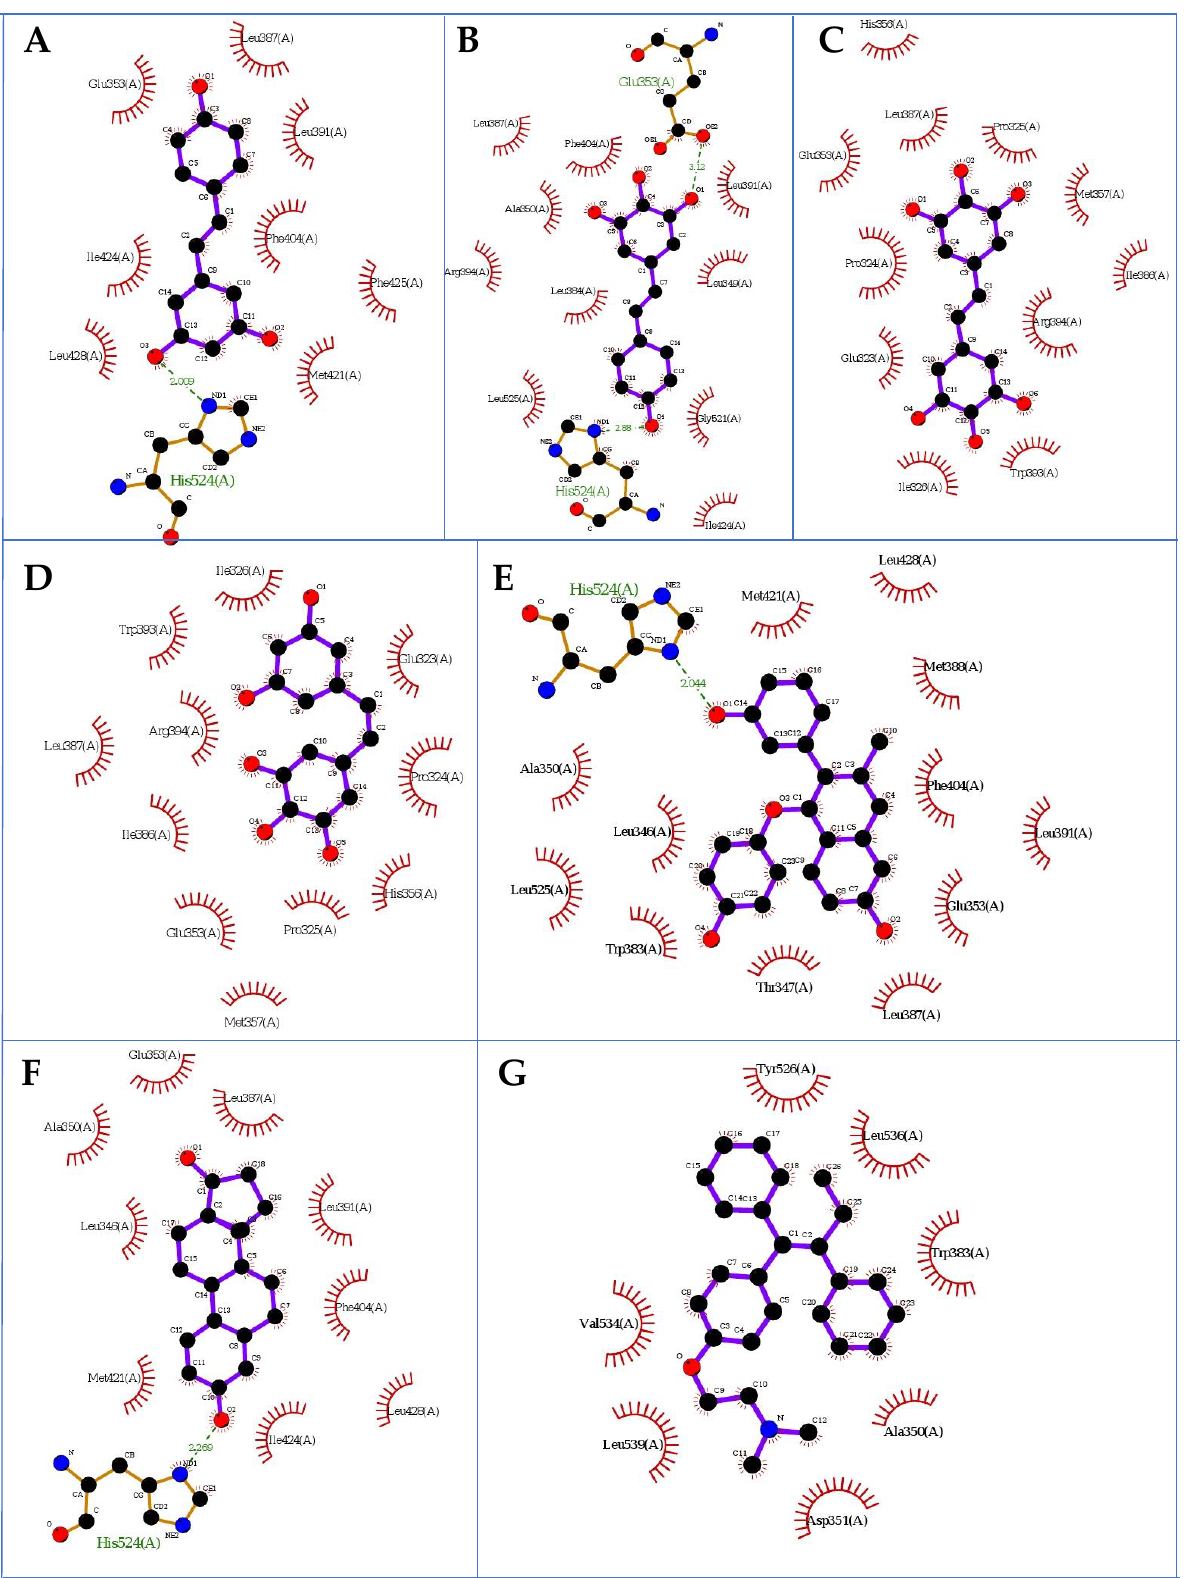
Figure 3. The first poses of the docked ligands to ER α : ( A ) resveratrol, ( B ) M8 , ( C ) M12 , ( D ) M11 , ( E ) tamoxifen, ( F ) estradiol and ( G ) GW368; hydrogen atoms are omitted; 3dt3.pdb protein (LigPlot+ v.2.2 software).